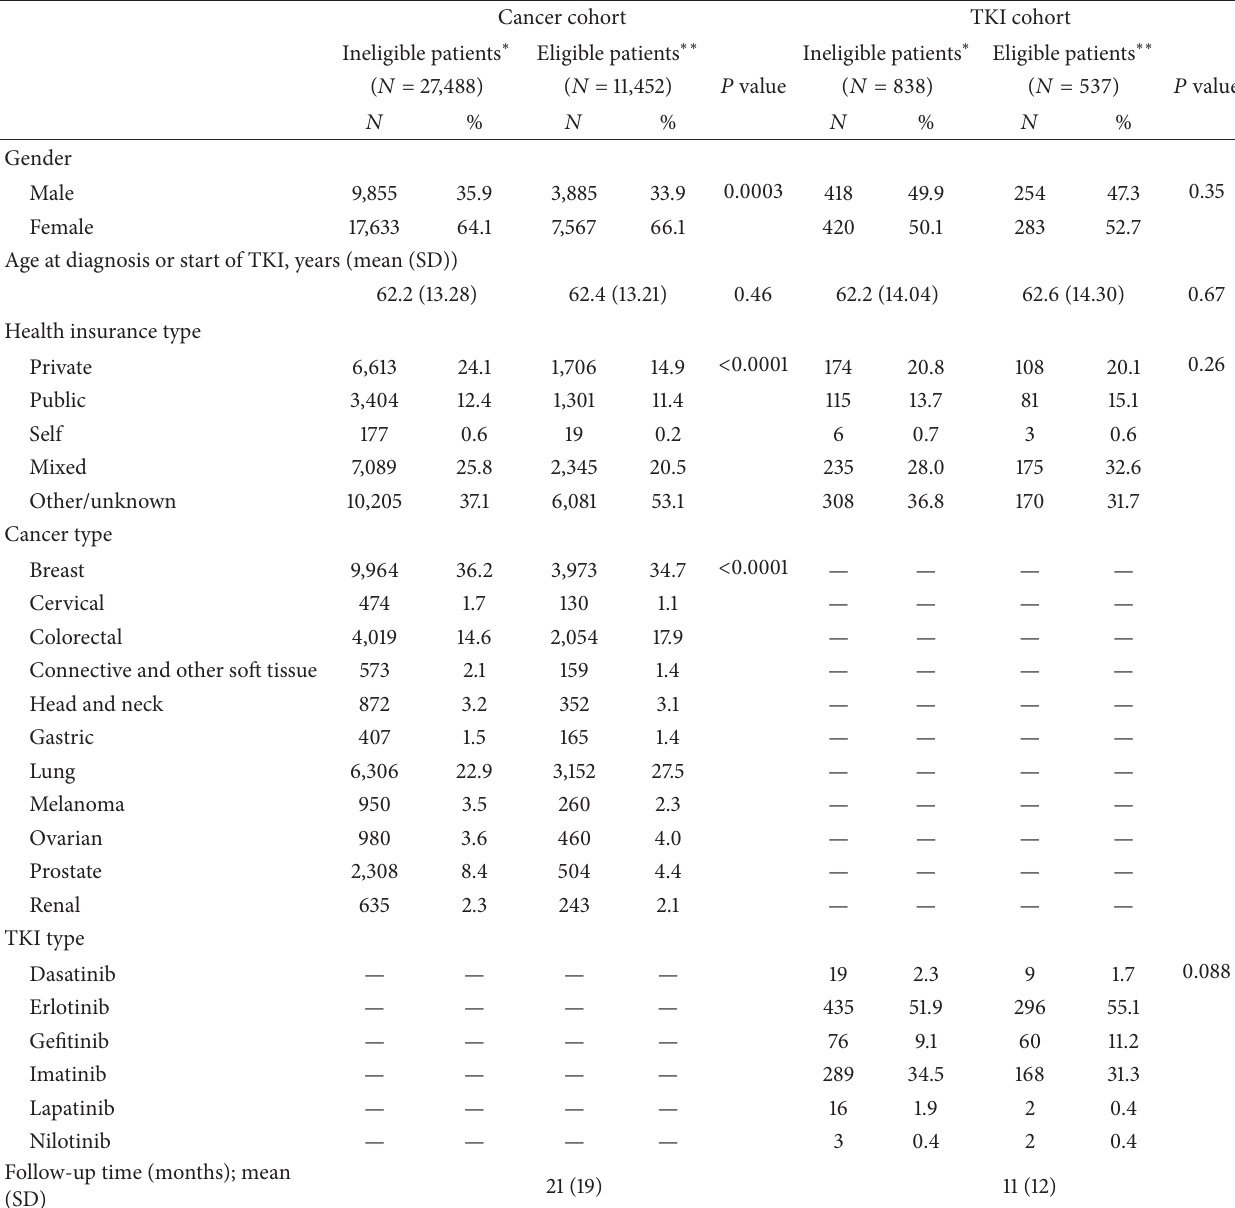
Table 1: Baseline demographics for ineligible patients and eligible patients: EMR